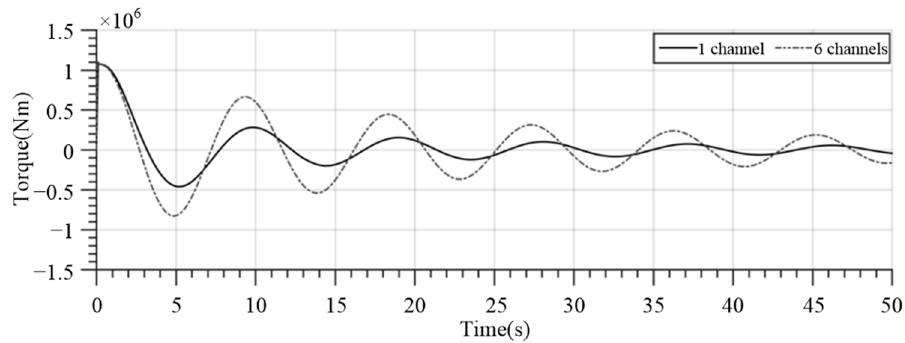
Figure 7. Free decay curves with 1 channel and 6 channels.